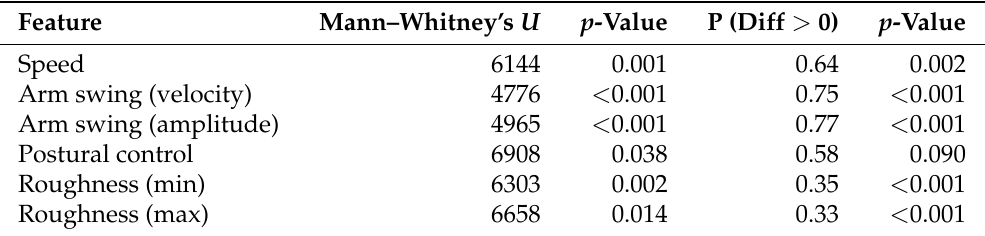
Figure 7. Distributions showing the change in each feature value related to medication ( n = 126, in each subplot), with the mean value marked as an orange dashed line. The change is calculated as the feature value during the ‘on medication’ assessment, of the levodopa challenge, minus the ‘off medication’ assessment. As the medication generally improves motor function for PD patients, the directions of change make sense intuitively (see also Figure 5). For example, feature values related to speed and arm swing increased after taking medication. For most features, the change in feature value was significant (see Table 3). Table 3. Results of Mann–Whitney U tests [45] for the difference between feature values from ‘on medication’ and ‘off medication’ assessments, alongside the probability of this difference being greater than zero and the corresponding binomial test (two-sides test for this probability differing from